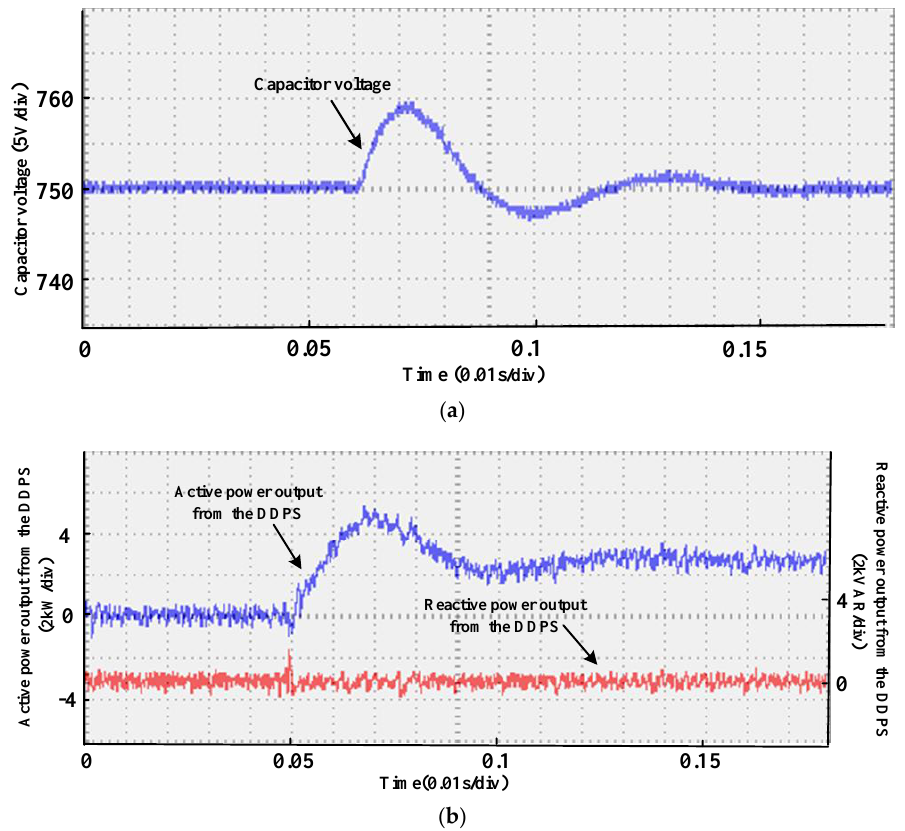
Figure 14. The verification results: ( a ) the DC-side capacitor voltage; and ( b ) active and reactive power output from the DDPS.